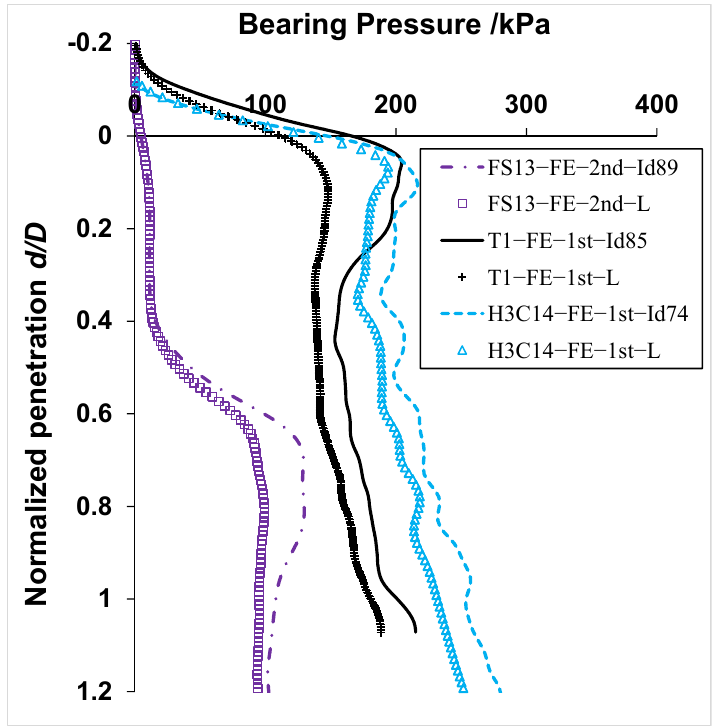
Figure 5. Comparison of penetration resistance profiles between cases using different sand relative density I D .